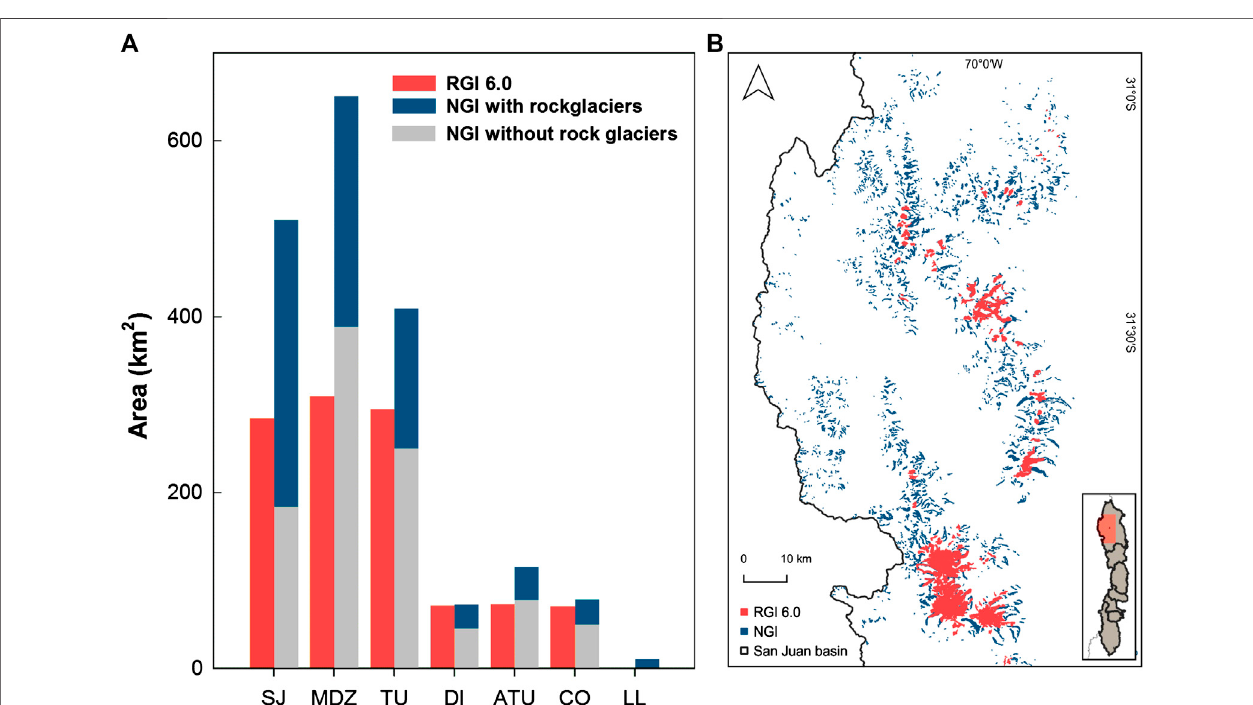
FIGURE 7 | (A) Comparison of results from the RGI version 6.0 and NGI for the main river basins in the study area: San Juan (SJ), Mendoza (MDZ), Tunuyán (TU), Diamante(DI),Atuel(ATU),Colorado(CO)andLlancanelo(LL). (B) ExamplefromtheSanJuanriverbasinshowingthedifferencesinglacieroutlinesbetweentheRGIand the